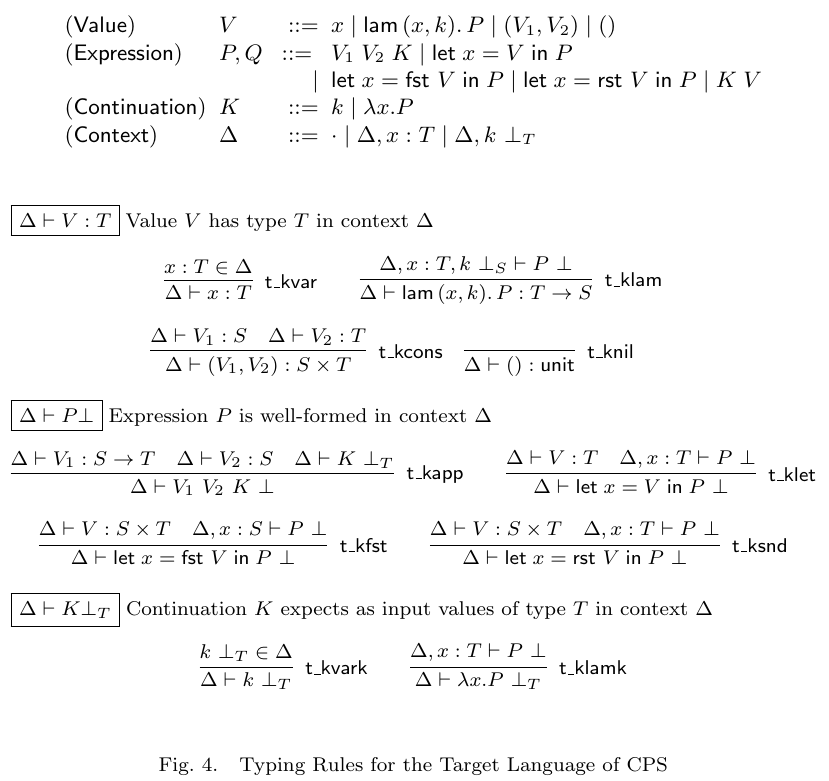
Fig. 4. Typing Rules for the Target Language of